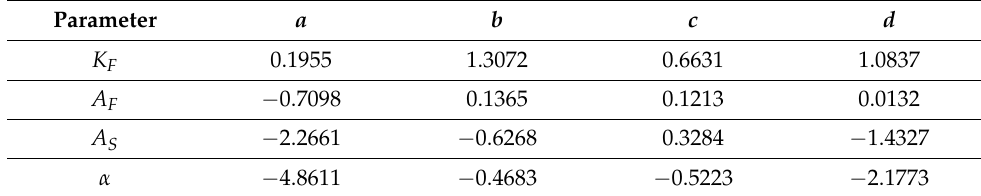
Table 1. Derived power of TSM empirical equations by PCR.